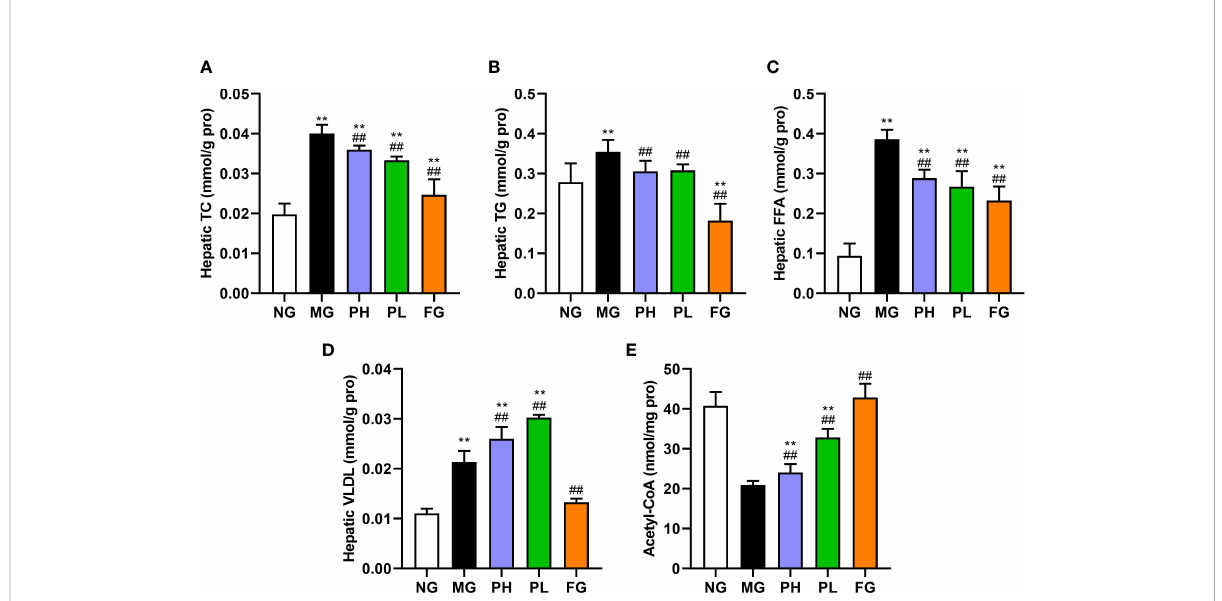
FIGURE 2 Effect of puerarin on hepatic lipid. (A) Hepatic TC; (B) hepatic TG; (C) hepatic FFA; (D) hepatic VLDL; (E) hepatic acetyl-CoA. Data were expressed as mean ± SD (n = 10). **p < 0.01, vs . NG; ## p < 0.01, vs . MG.